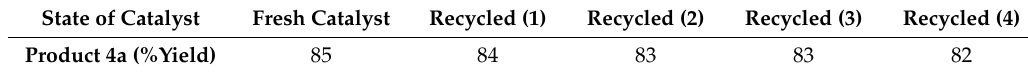
Figure 5. Optimization of the chitosan graft copolymer as a basic catalyst. Table 1. Recyclability of the chitosan graft copolymer as basic catalyst.